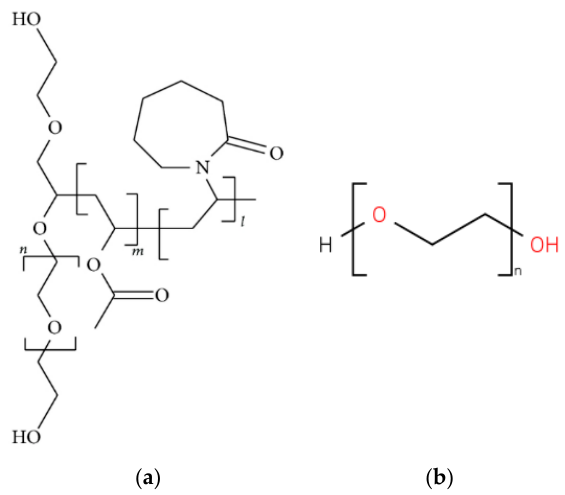
Figure 1. Chemical structure of the excipients ( a ) Soluplus ® and ( b ) polyethylene glycol (PEG).